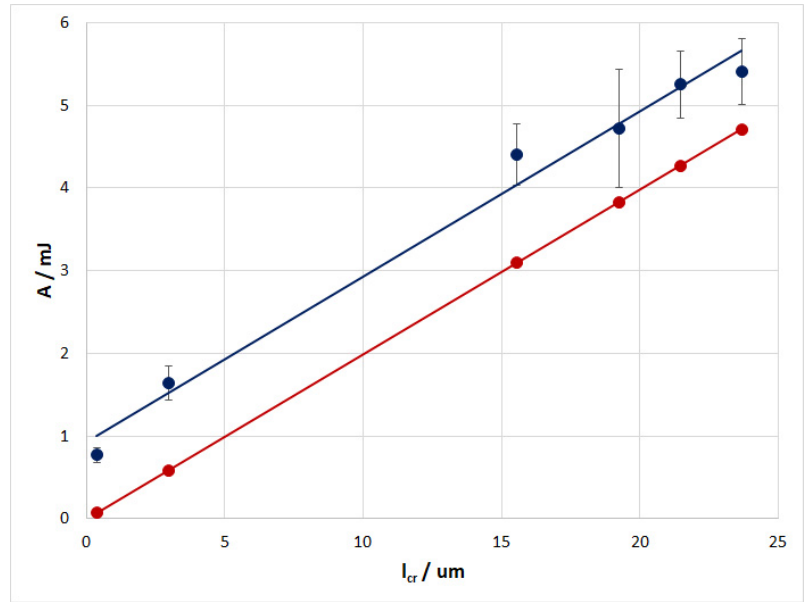
Figure 12. Experimental dependence of the work of fracture of the composite wire (blue line) and the calculated dependence of the work expended in overcoming the friction force (red line) on the critical length of the fiber.